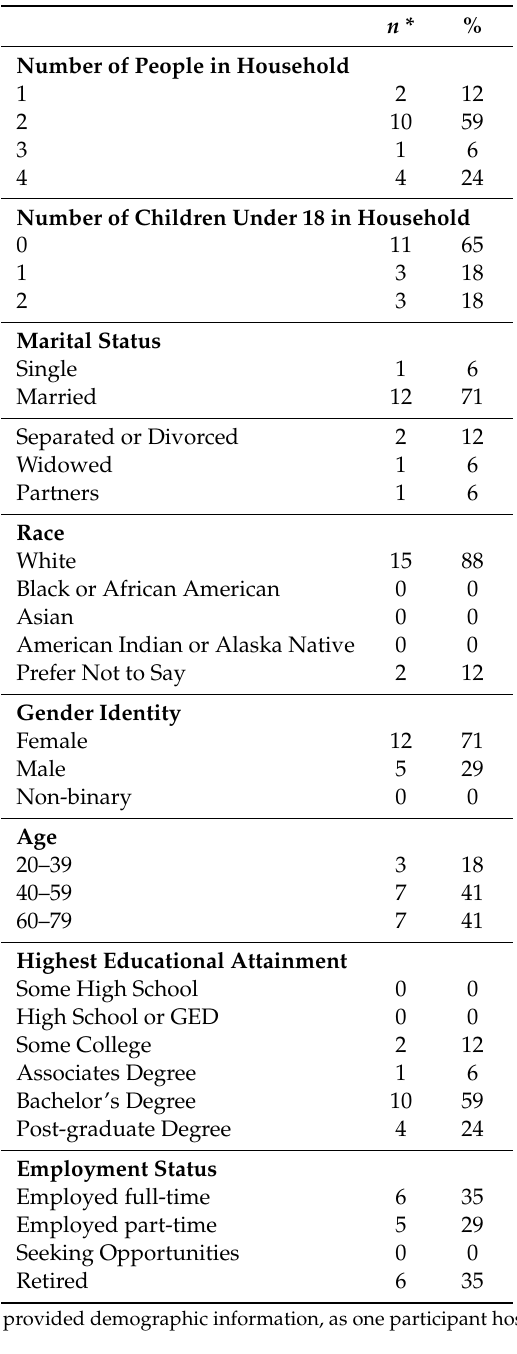
Table 1. Clean Air Ambassador demographic